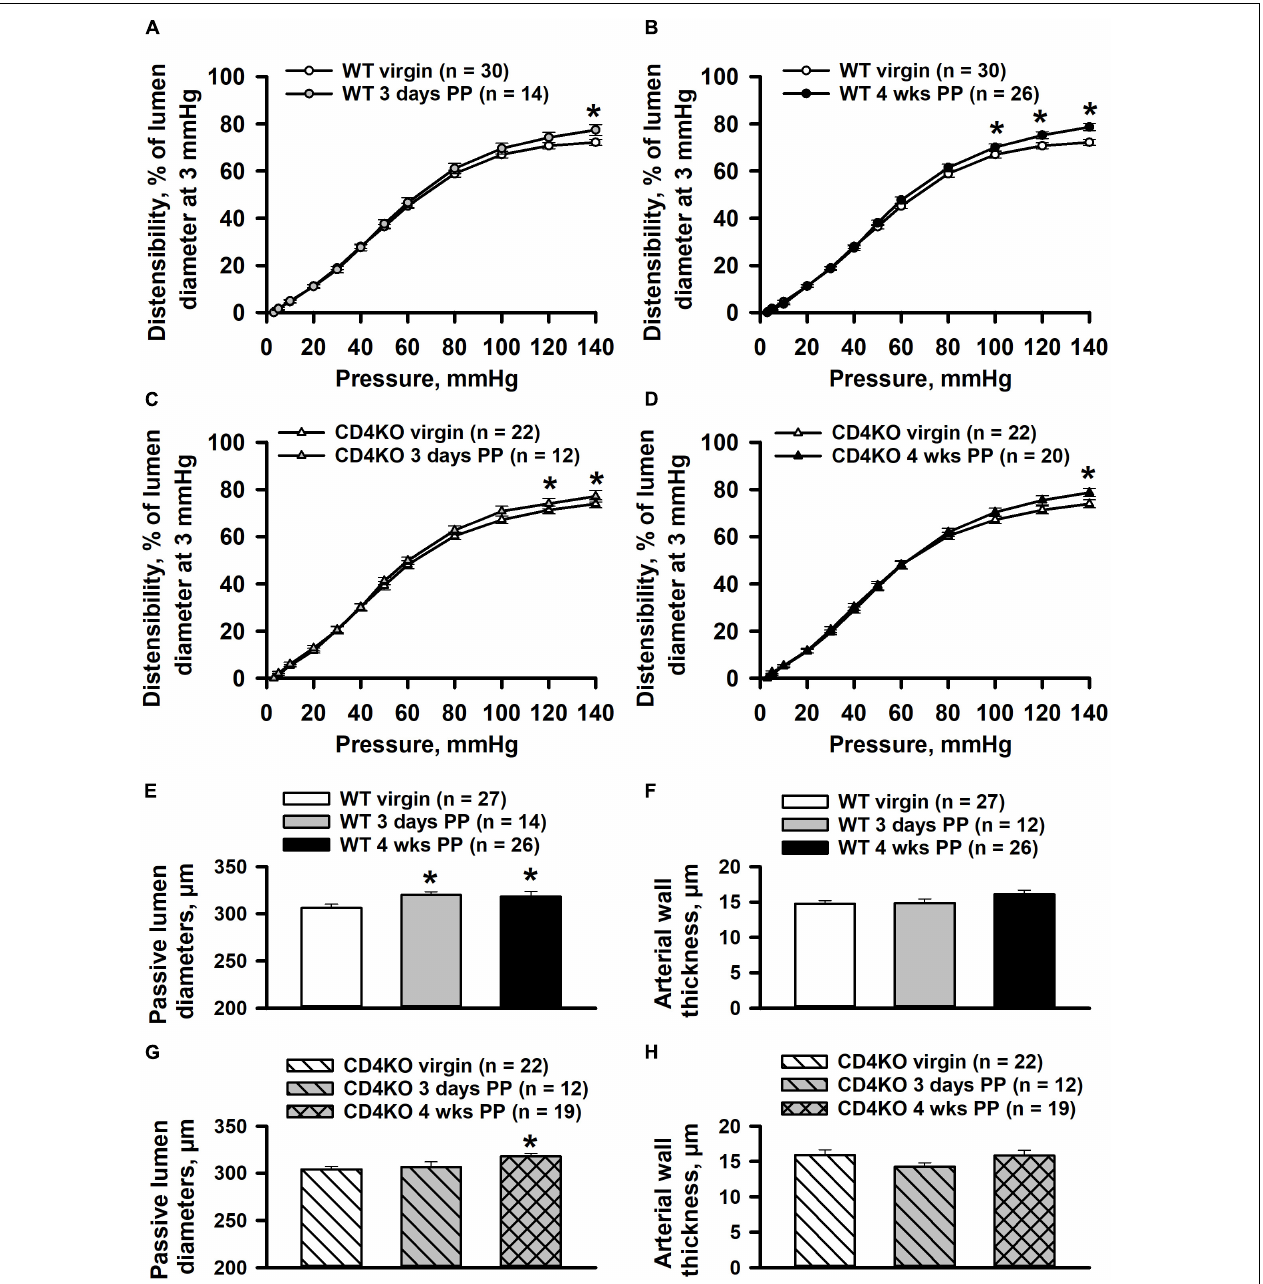
FIGURE 9 | Effects of pregnancy on distensibility and structural parameters of internal carotid arteries (ICAs) from wild-type (WT) and CD4 T cell deficient (CD4KO) mice. Summary graphs showing changes in distensibility of arteries from WT (A,B) and CD4KO (C,D) mice before pregnancy (virgin), 3 days and 4 weeks postpartum (PP). Distensibility is expressed as the percentage of pressure-induced changes in passive lumen diameters relative to that of an un-stretched arteries at 3 mmHg. Significant changes in distensibility of PP arteries were observed only at high levels (100–140 mmHg) of intraluminal pressure (*significantly different at P < 0.05 two way ANOVA). Summary graphs showing passive lumen diameters (E) and wall thicknesses (F) of ICAs from WT virgin and PP mice (*significantly different at P < 0.05, one way ANOVA). Bar graphs demonstrating a significant increase in diameters (G) and unaltered wall thickness (H) of arteries from CD4KO PP mice (*significantly different at P < 0.05, one way